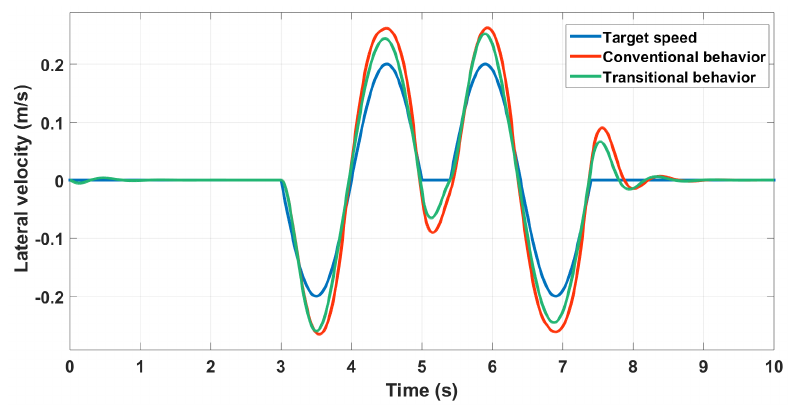
Figure 23. Lateral speed control using GS H ∞ .